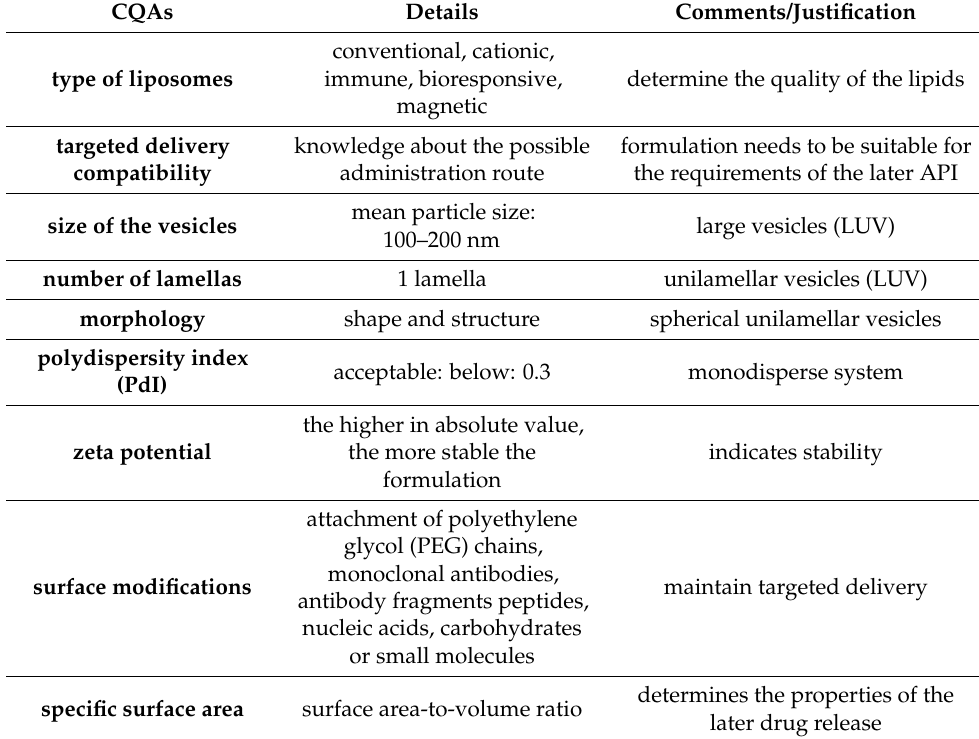
Table 6. CQAs of the “intermediate”, API-free liposomal